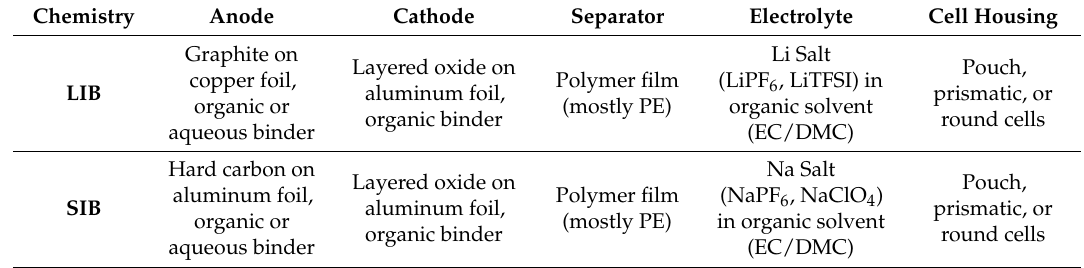
Table 1. Key components of lithium-ion and sodium-ion batteries (LIBs and SIBs). Major differences